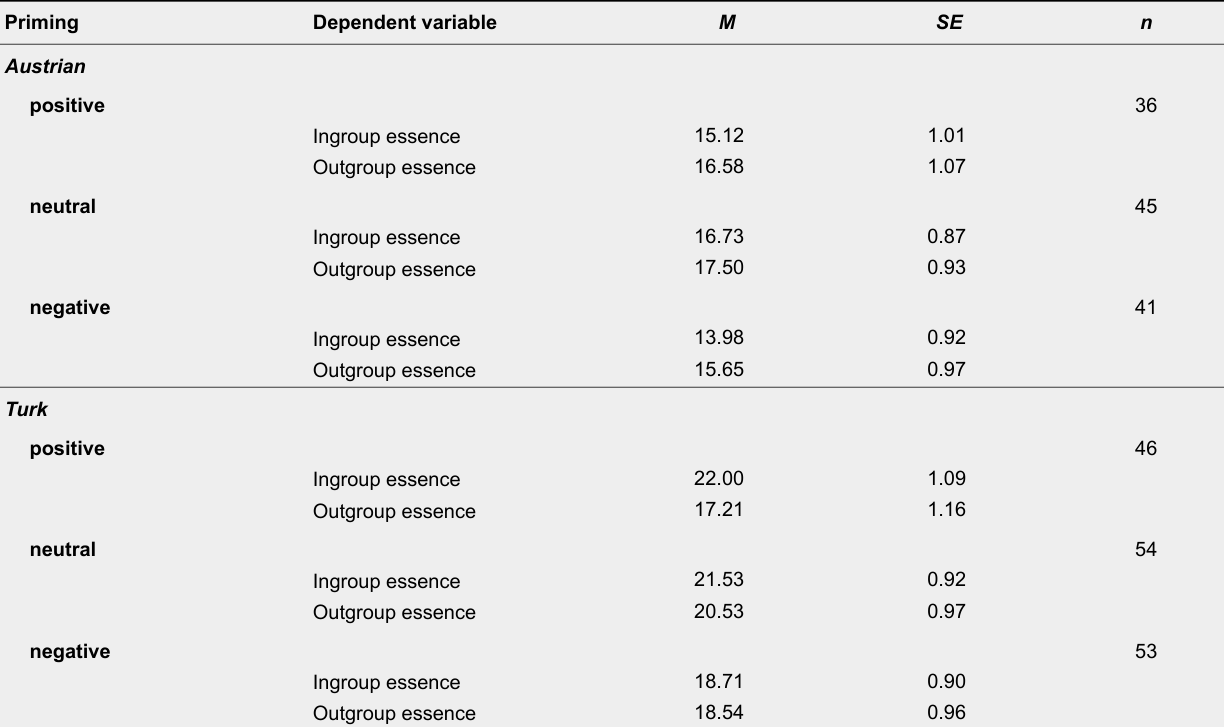
Means and Standard Error Values of Ingroup and Outgroup Essentialism of Austrian and Turkish Participants in Different Priming